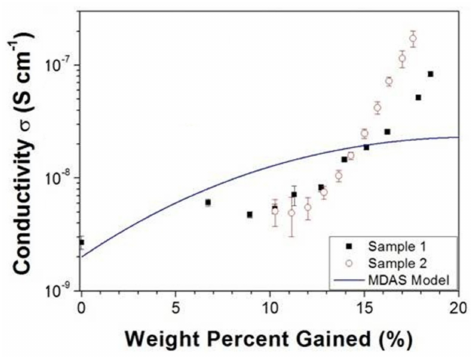
Figure 10. An example of the hydration dependent conductivity of melanin at room temperature. Shown are two different samples as well as a theoretical curve that represent the amorphous semi- conductor model. Reproduced from A.B. Mostert, B.J. Powell, I.R. Gentle, P. Meredith, Appl. Phys. Lett. , 2012, 100, 093,701 [106], with the permission of AIP